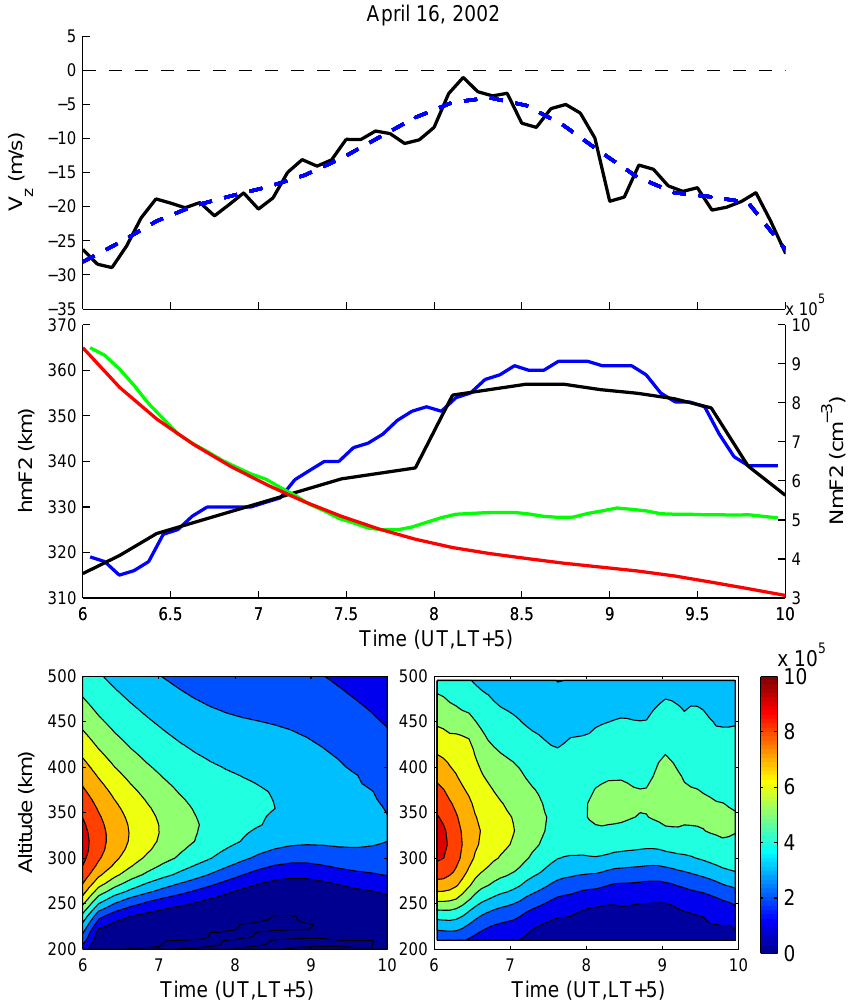
Fig. 10. Data and simulations on 16 April 2002. The top panel is the vertical drift measured by Jicamarca (black solid) and the drift used in the model run (blue dashed). The second panel is hm F2 (measured in blue, modeled in black) and Nm F2 (measured in green, modeled in red). The lower panel is a density contour plot of the model (left) and measurements (right).